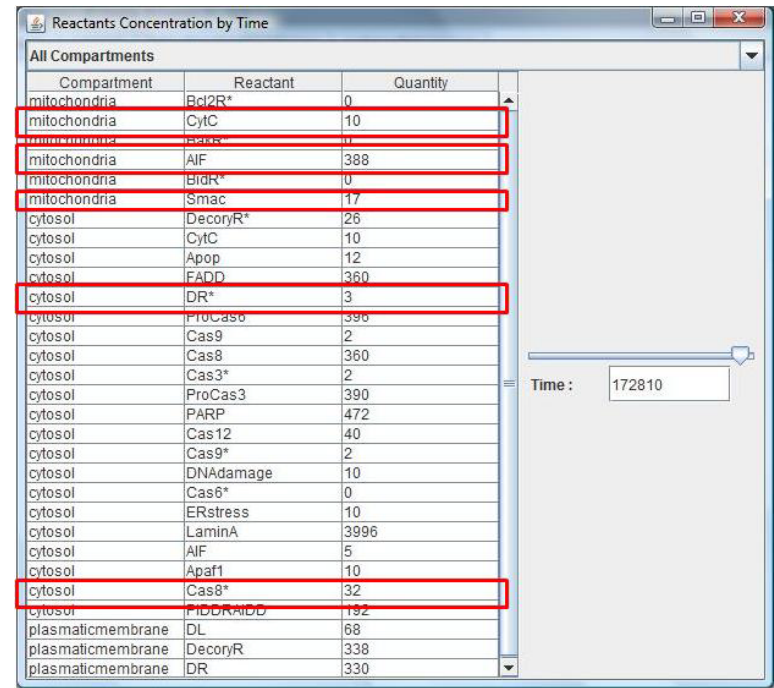
Figure 7: Concentration-time table: connection between extrinsic and intrinsic